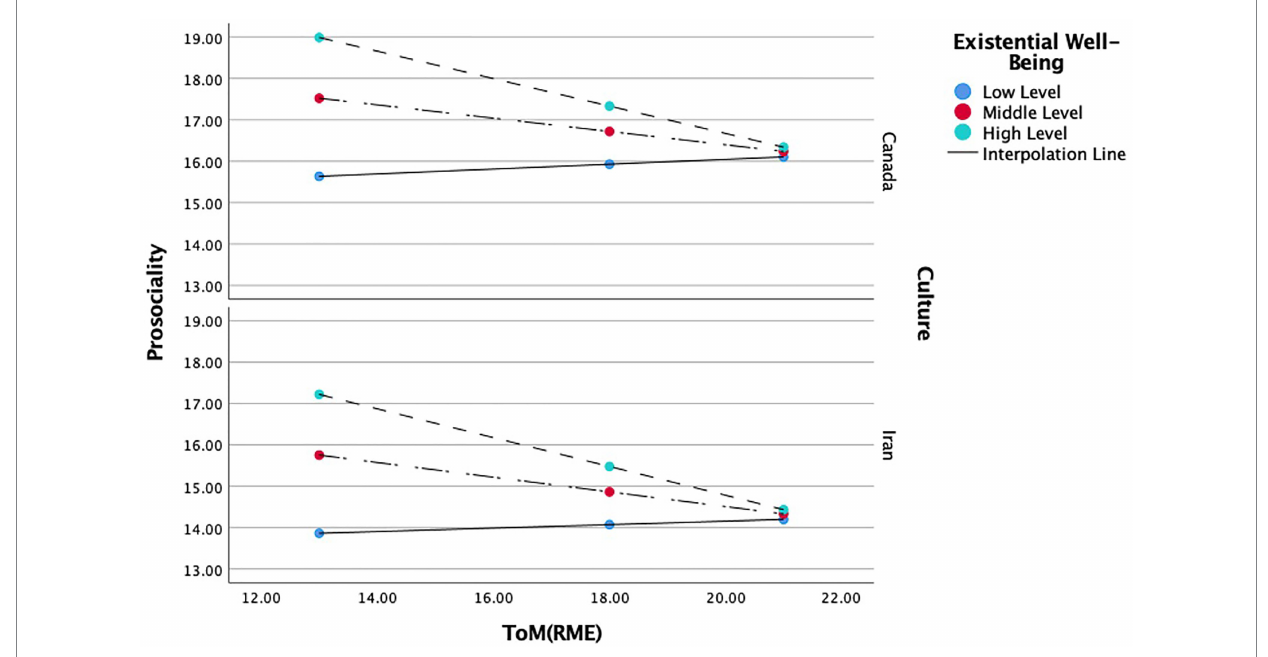
FIGURE 5 Moderating role of existential well-being and culture in the relationship between ToM and